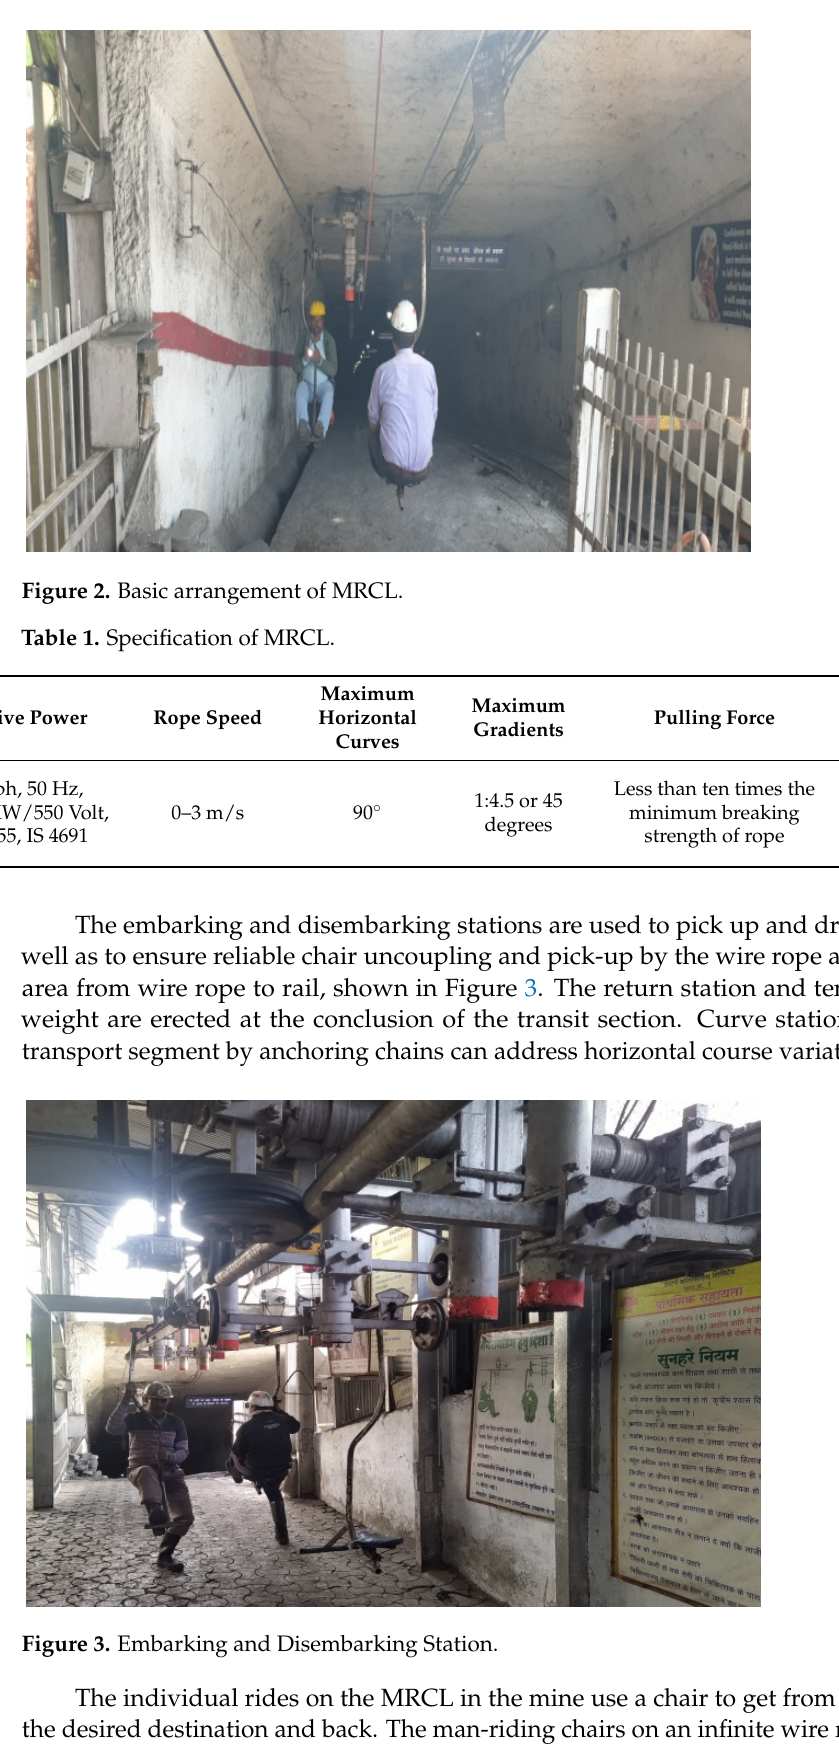
Table 1. Specification of MRCL.